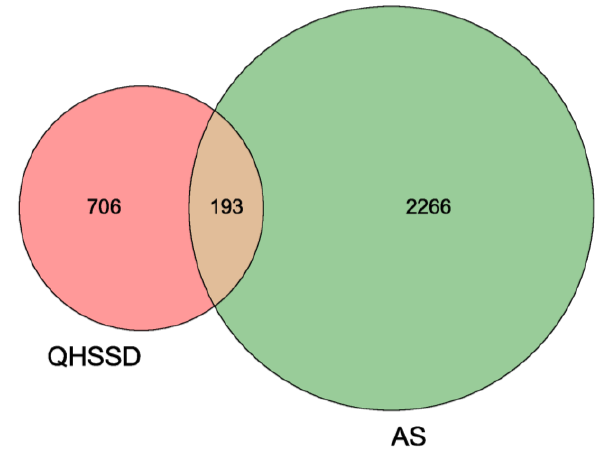
Figure 2. Overlapping potential targets between QHHSD and AS.